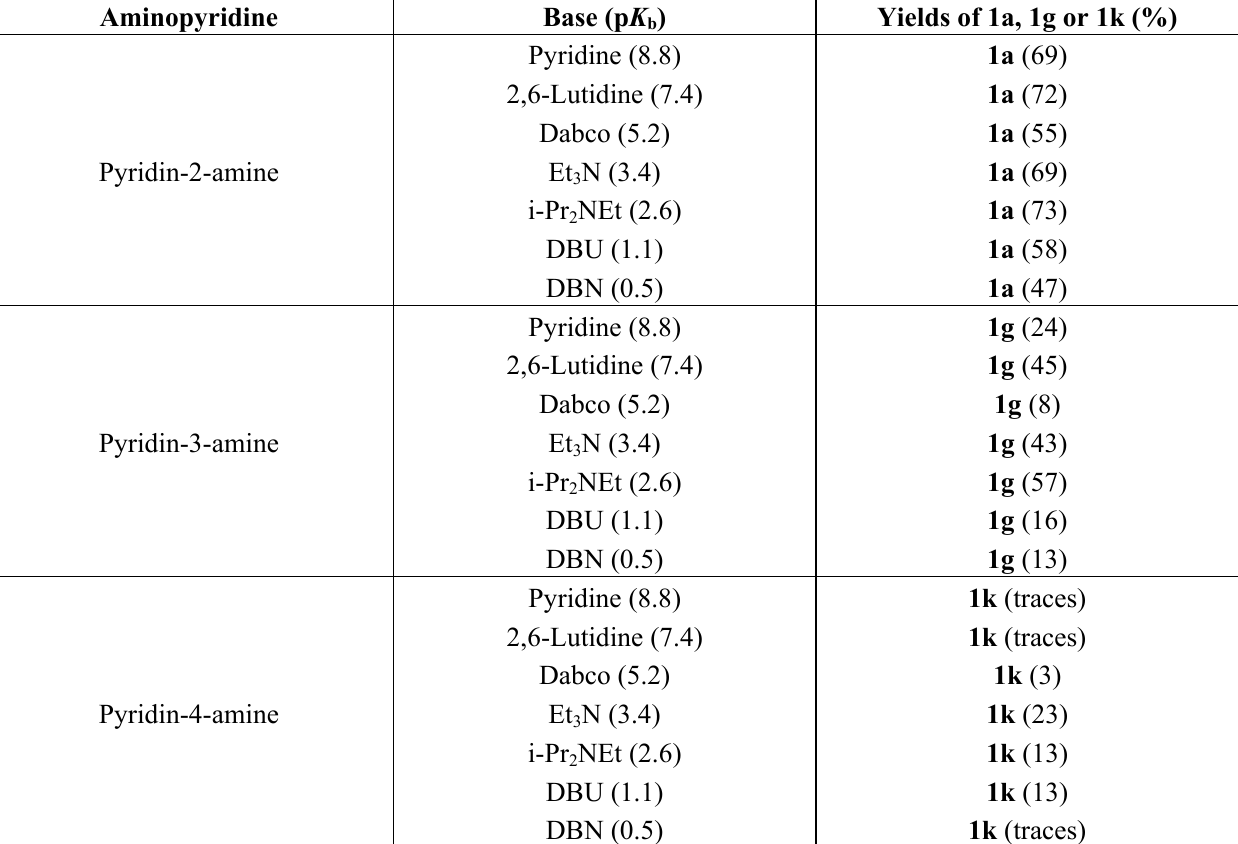
Table 1. Reaction of Appel salt 4 (2.18 mmol) with aminopyridines (2.18 mmol) in DCM (4 mL) at ca. 20  C for 1 h and followed by base (4.36 mmol) for another 2